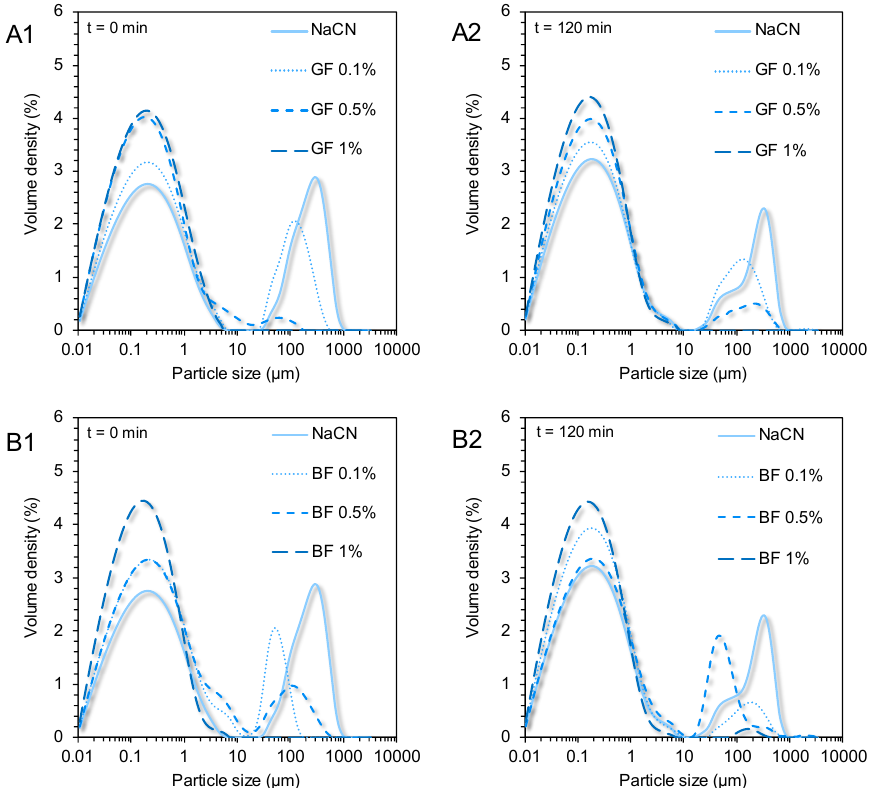
Figure 5. Particle size distribution profiles of the initial and end NaCN-based gastric phases ( 1 : t = 0 min and 2 : t = 120 min) as influenced by the phenotype and concentration of flaxseed gum. ( A1,A2 ) = golden flaxseed and ( B1,B2 ) = brown flaxseed.